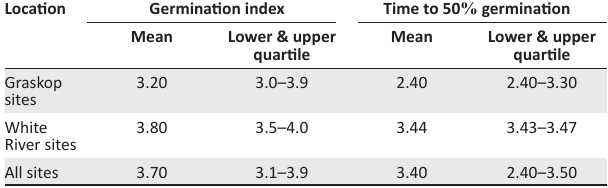
FIGURE 10: Histogram of the time taken to reach 50 % germination. TABLE 2: Summary of the descriptive statistics of eucalyptus seeds germination.